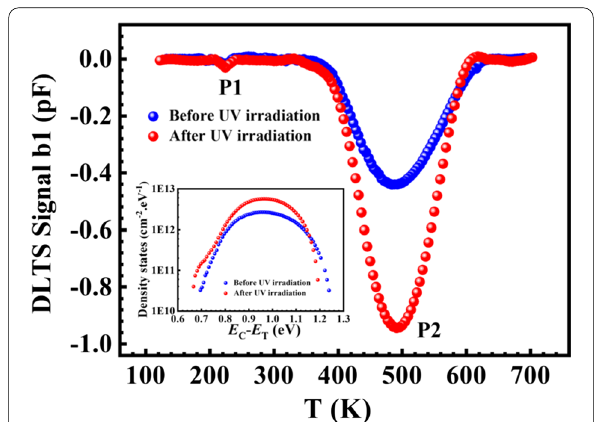
Fig.6 DLTS spectra for 4H-SiC PiN diodes before and after UV irradiation. The insert shows the D it distributions for 4H-SiC PiN diodes before and after UV